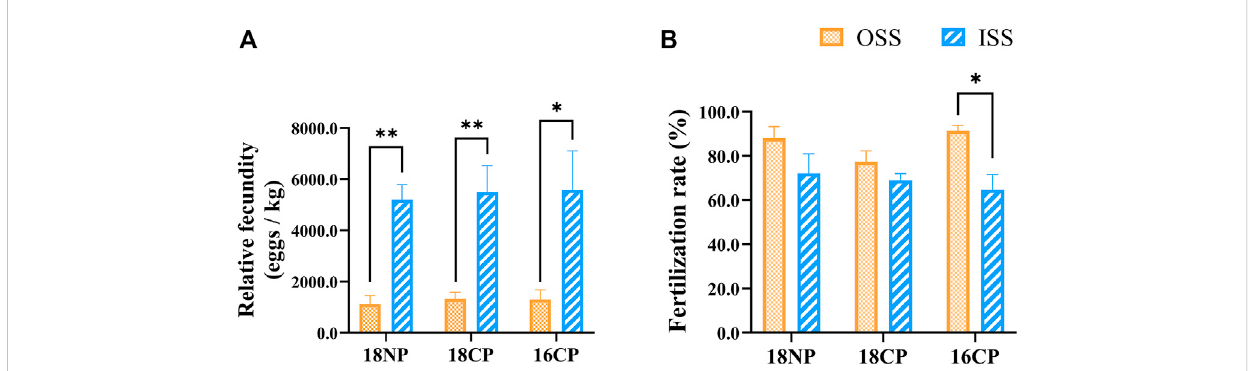
FIGURE 10 Relative fecundity and fertilization rate in out-of-season spawning (OSS) and in-season spawning (ISS). (A) Relative fecundity, i.e., spawned egg numbers relative to female weight. (B) Fertilization rate. 18NP , 18 ° C overwintering water temperature, natural photoperiod group. 18CP , 18 ° C overwintering water temperature, controlled photoperiod group. 16CP , 16 ° C overwintering water temperature, controlled photoperiod group. The broodstock of ISS came from the same group of fi sh in OSS. Asterisk (*) and double asterisk (**) indicate signi fi cant ( p < 0.05) and extremely signi fi cant ( p < 0.01) differences between OSS and ISS in each group,